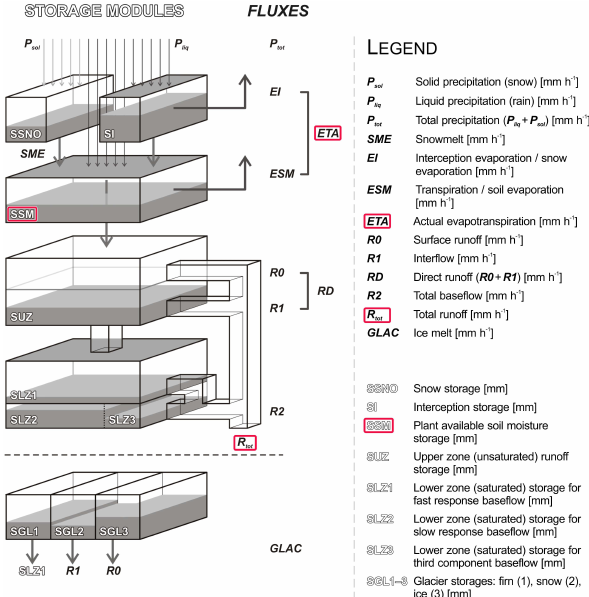
Fig. 3. Schematic of the modular model structure of PREVAH (modified after Viviroli et al., 2009a). The target variables analysed in this study are marked with red rectangles. Note that the model is driven by hourly input and, therefore, provides output in hourly resolution. For the analyses in this study the data are aggregated (cf. Sect.